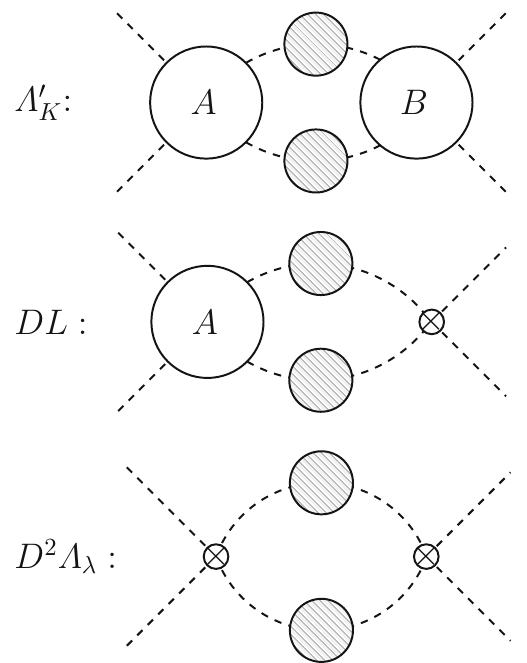
Fig. 6 Candy diagrams for F 2 ( yN ) . The basic diagram is the three- loop diagram Λ (cid:2) . The fermion loops A , B are either of the form N K (non-twisted) or T (twisted), cf. Fig. 4. The diagrams DL and D 2 Λ λ come from Λ (cid:2) when A or B are shrunk to a counterterm vertex D , K which is the same for N and